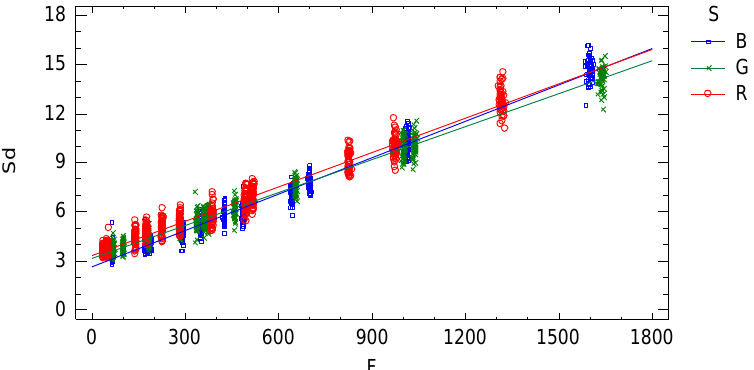
Figure 9. Interaction plot. Standard deviation Sd vs . adjusted radiometric values F depending on the wavelength factor. It is the characterization of the sensor noise (standard deviation) of a sequence of images according to the influential factors.